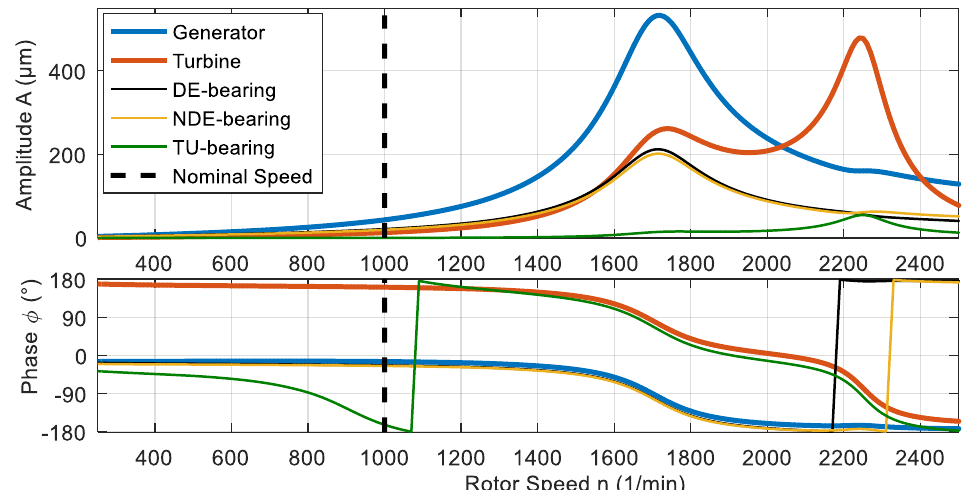
Figure 11. Bode plot: absolute amplitudes of generator and turbine, relative bearing amplitudes, unbalance G6.3 (100%), variant 1.